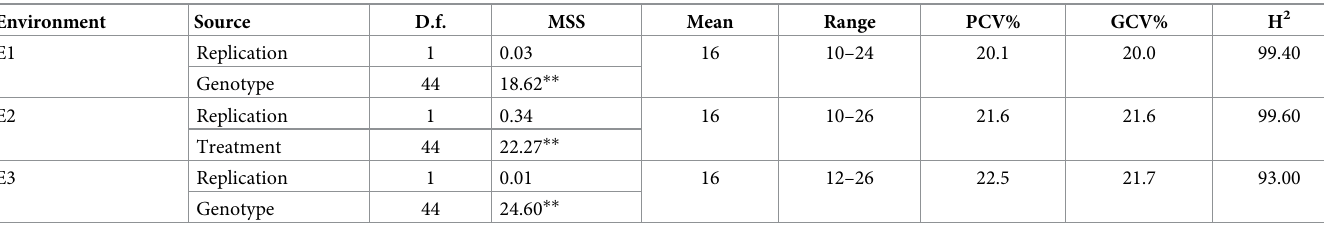
Table 1. Variability parameters of KRN trait across the location and seasons.